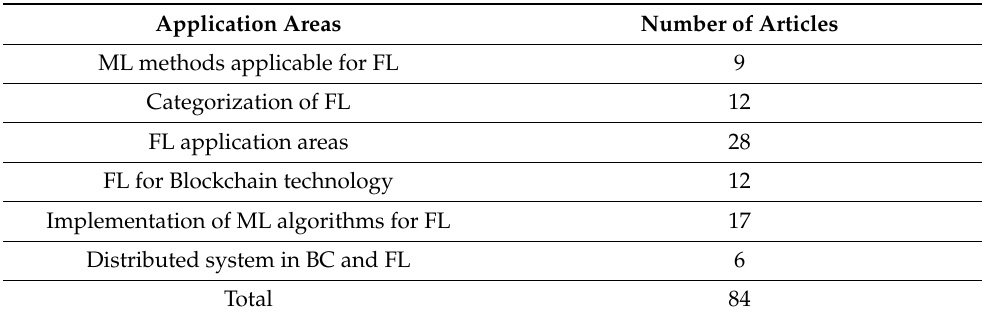
Figure 5. Categorization of primary articles based on a present review on FL. Table 4. Summary of some selected studies and number of articles